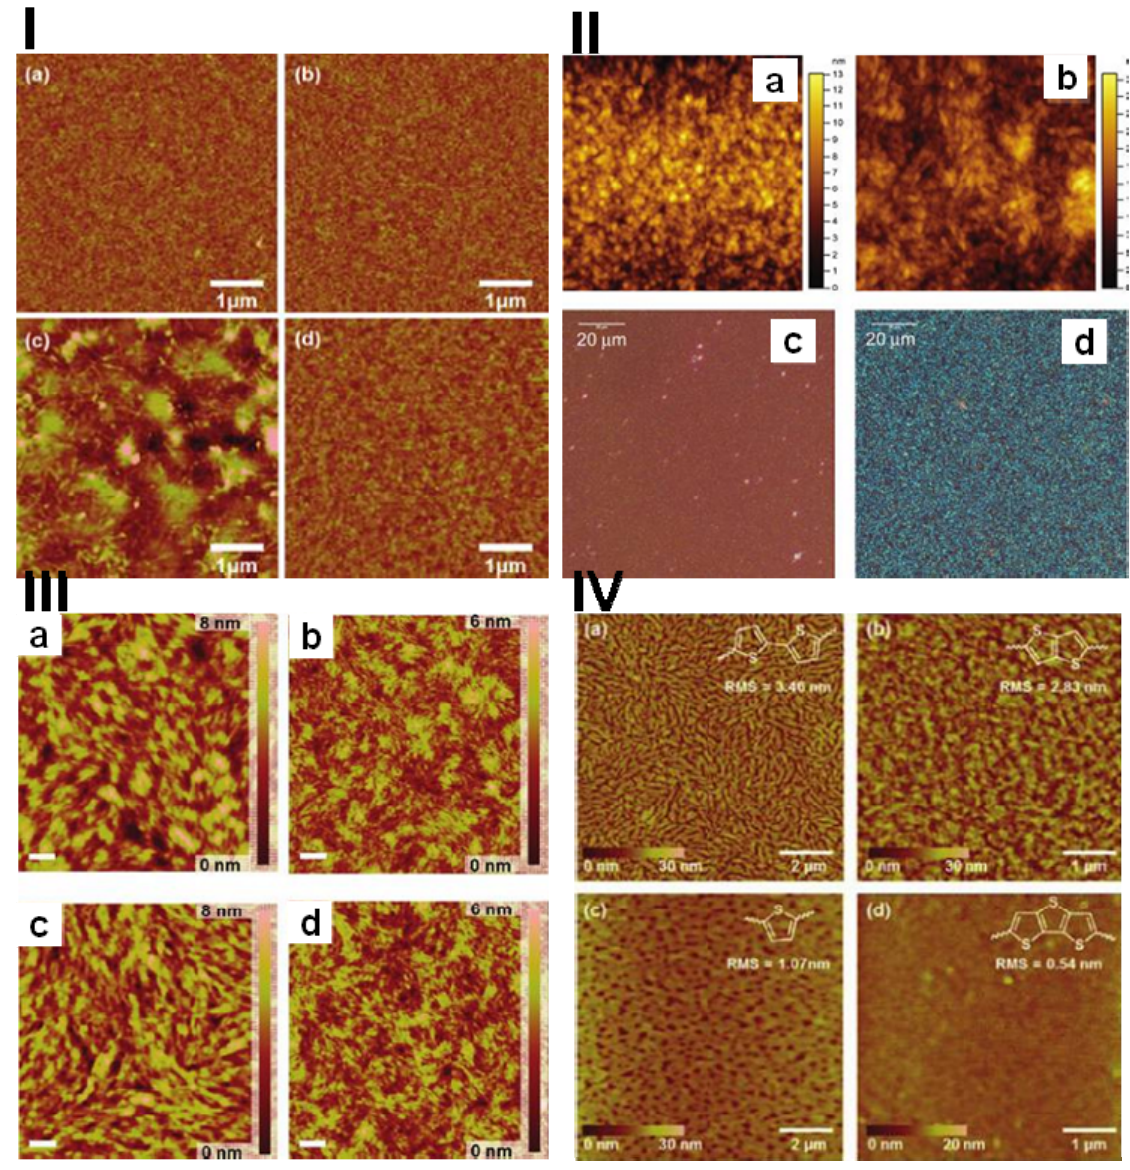
Figure 9. ( I ) Atomic force microscopy height images for ( a ) as-spun films of